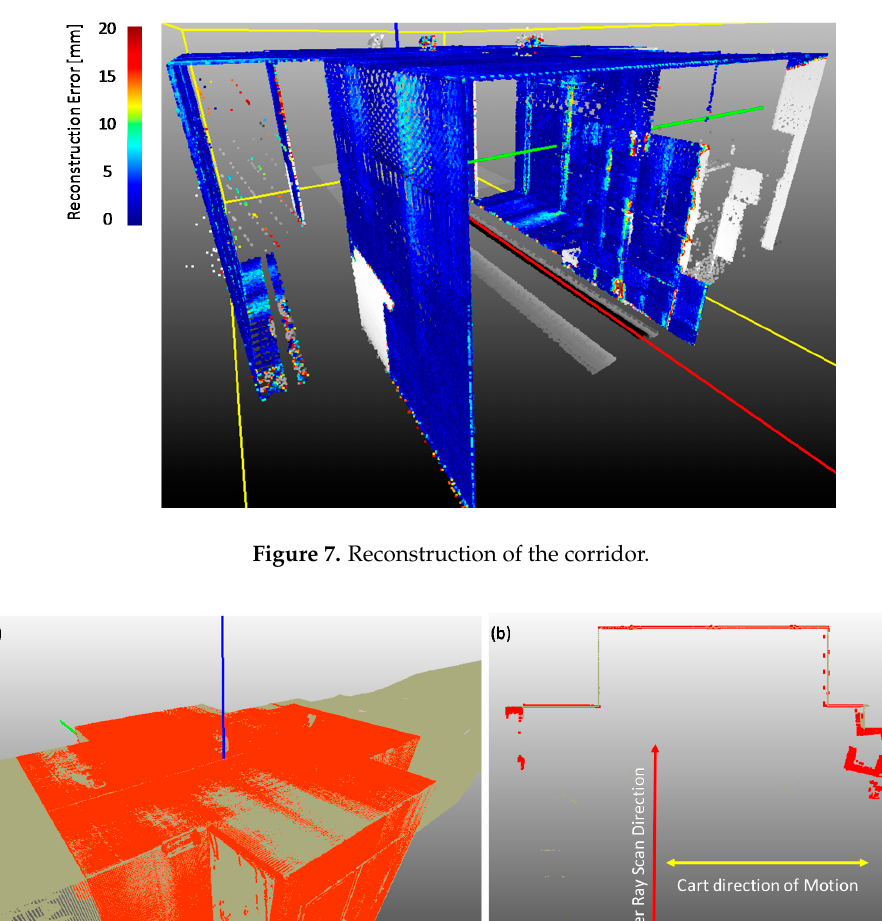
Figure 8. Differences between the static scan and a dynamic scan in indoor tests: 3D view ( a ) and top view ( b ).